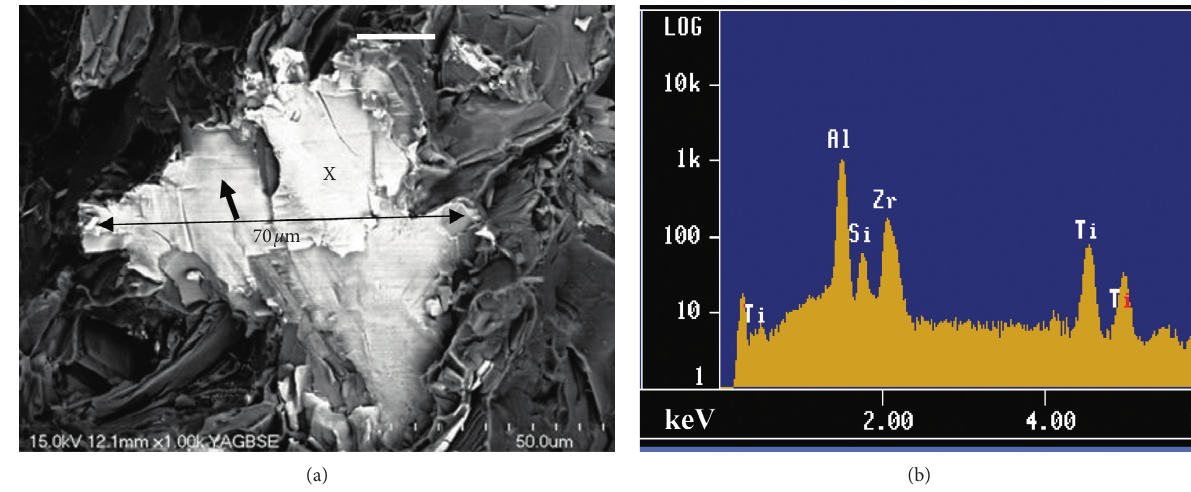
Figure 16: (a) Backscattered electron image of alloy F in the as-cast condition showing fracture of a massive Zr-rich phase, (b) EDS spectrum corresponding to the area marked X in (b), indicating (Al, Si) 3 (Zr,Ti) Table 4: Atomic radii of the main elements in (Al,Si)(Zr,Ti) phases. Element